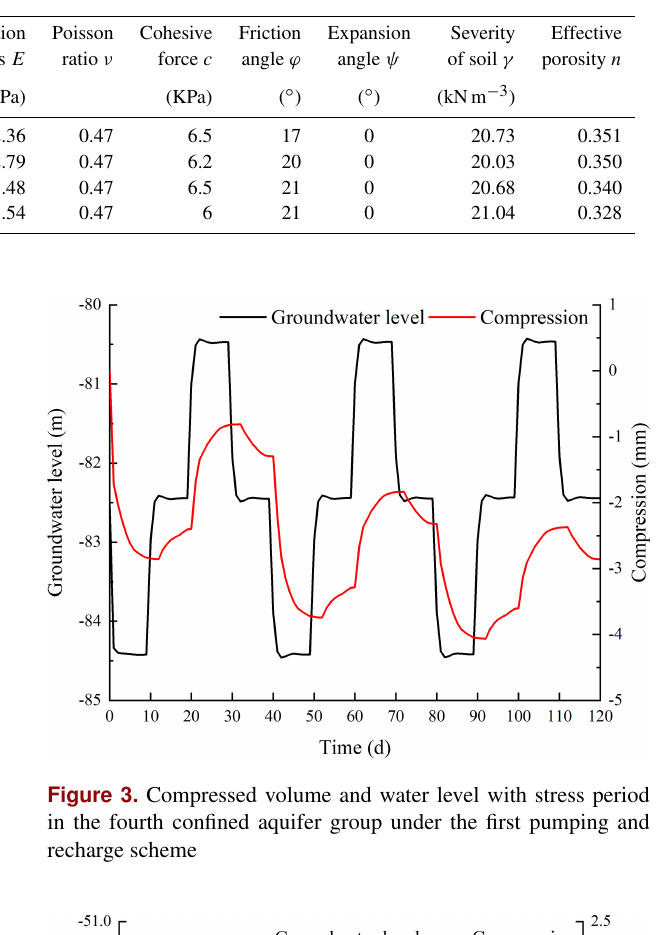
Table 1. Parameter zones and values.